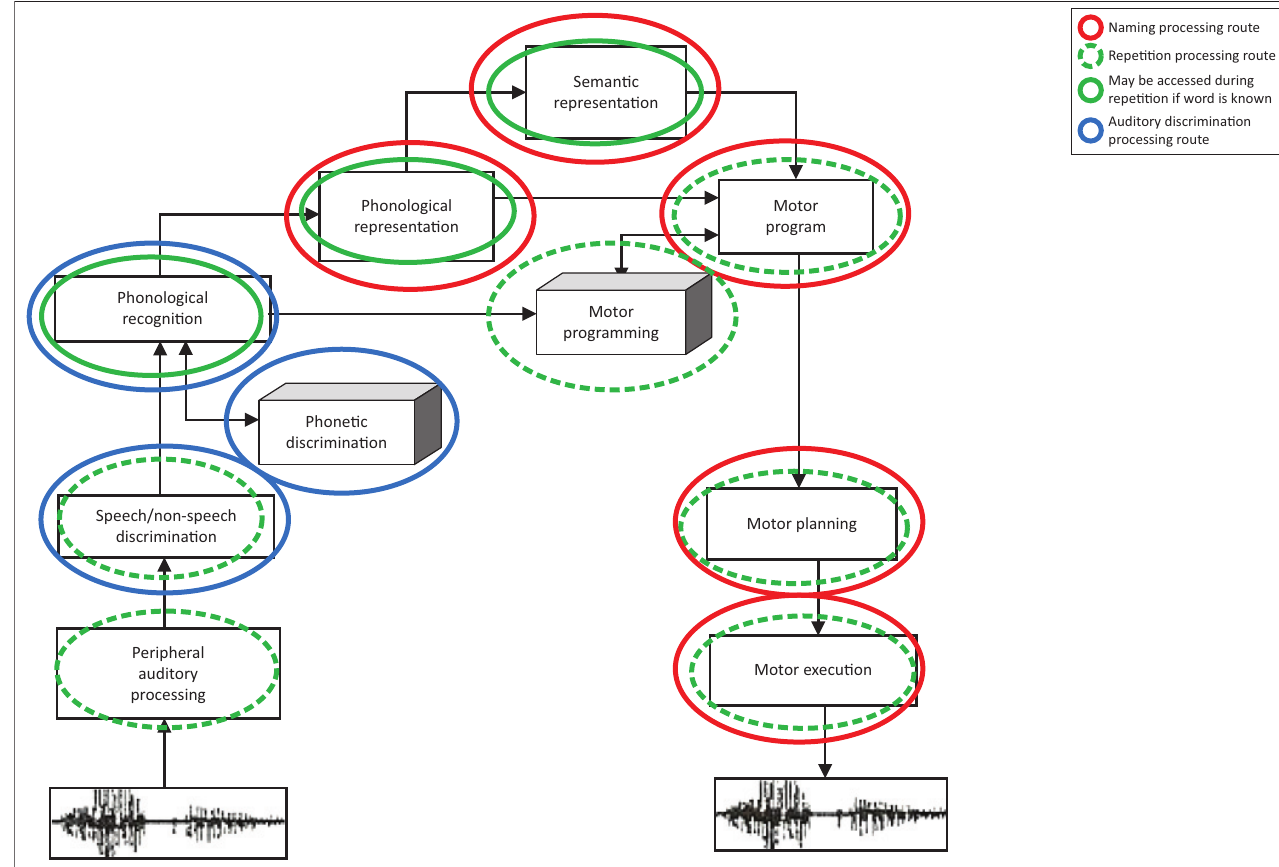
FIGURE 1: Simple speech processing model with processing routes indicated for three tasks.